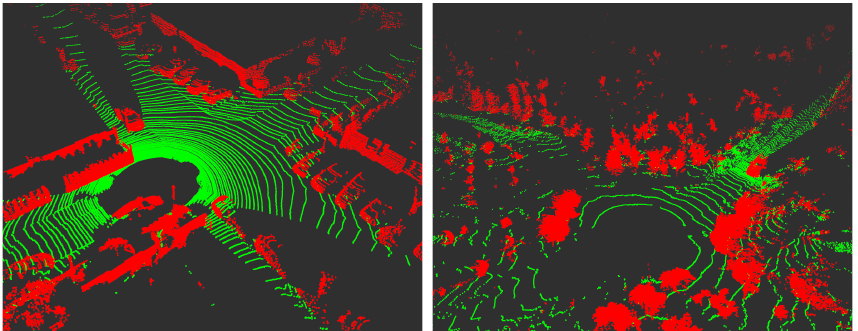
Figure 1. Illustration of the 3D point cloud segmentation applying JCP on the urban road ( left ) and the field road ( right ). Ground points are green; Obstacle points are